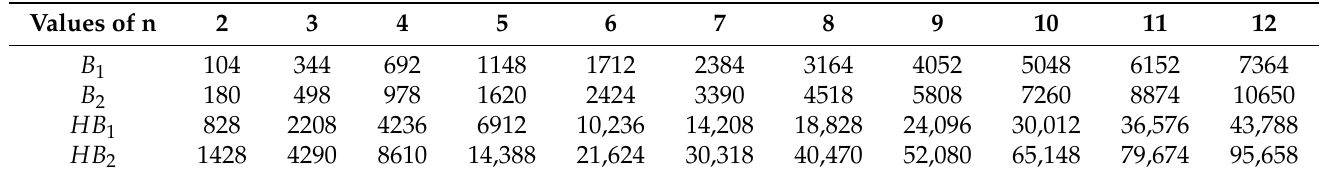
Table 6. Numerical comparison of topological indices of HB n .